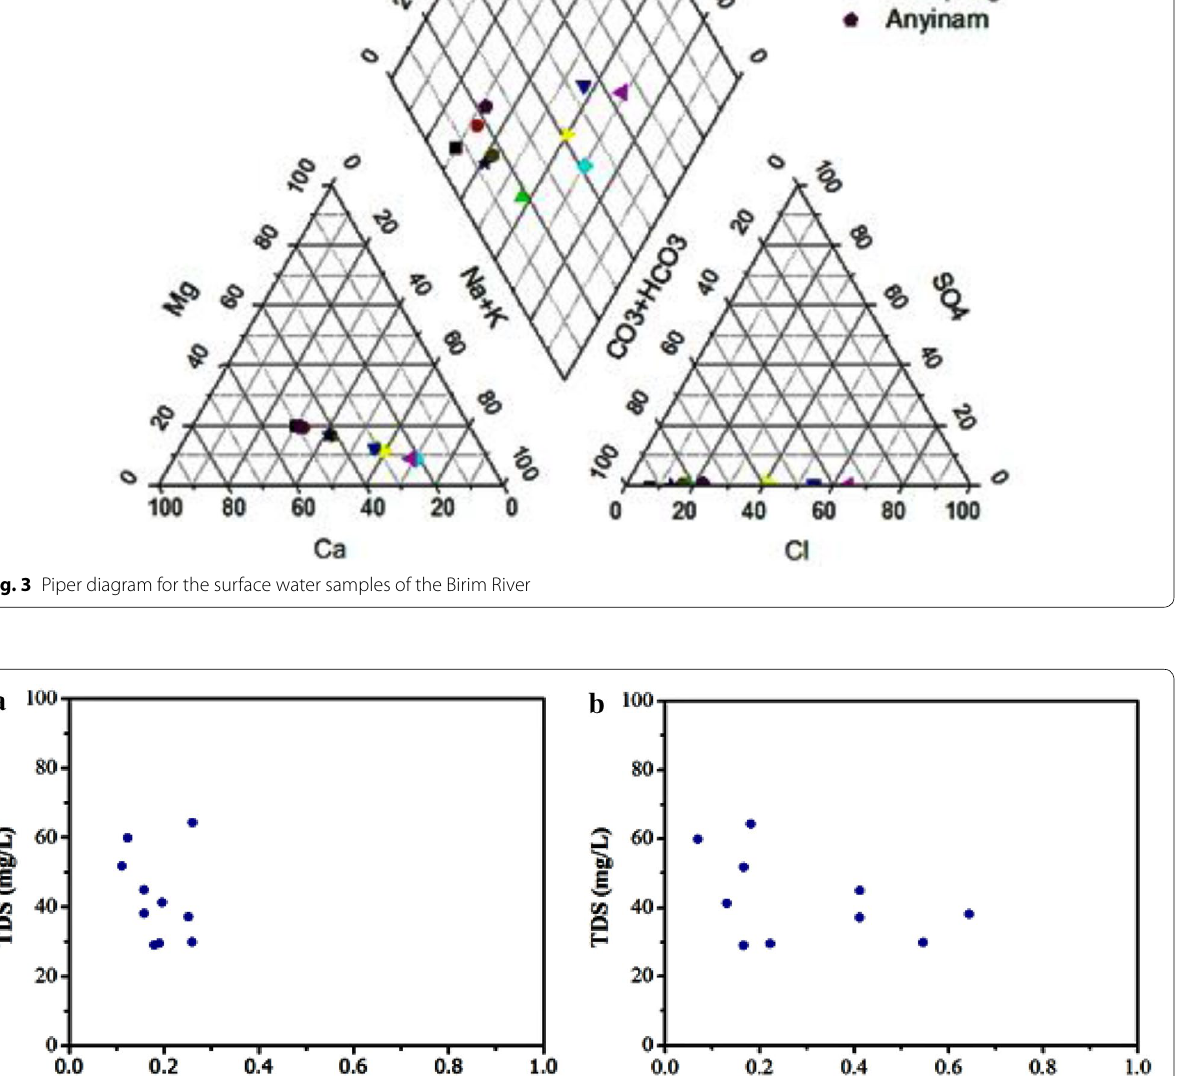
K + /(Na + K + Ca 2 + ) and b Cl − /(Cl − + + +